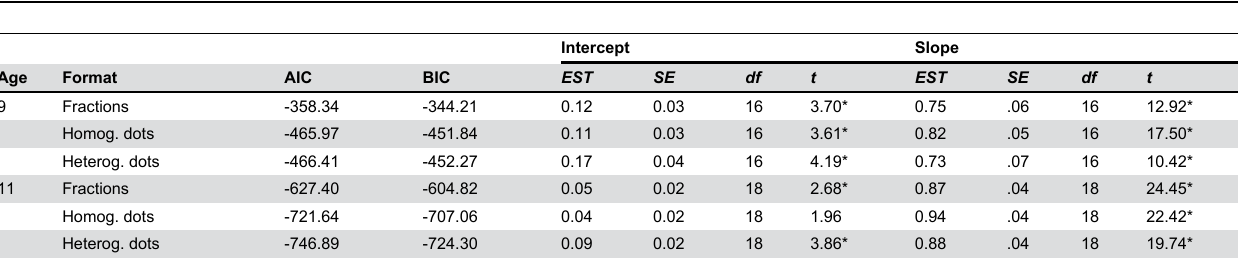
Table 3. Results of the linear mixed models run on the participants’ responses with the ratio magnitude as a predictor according to the age group and the ratio